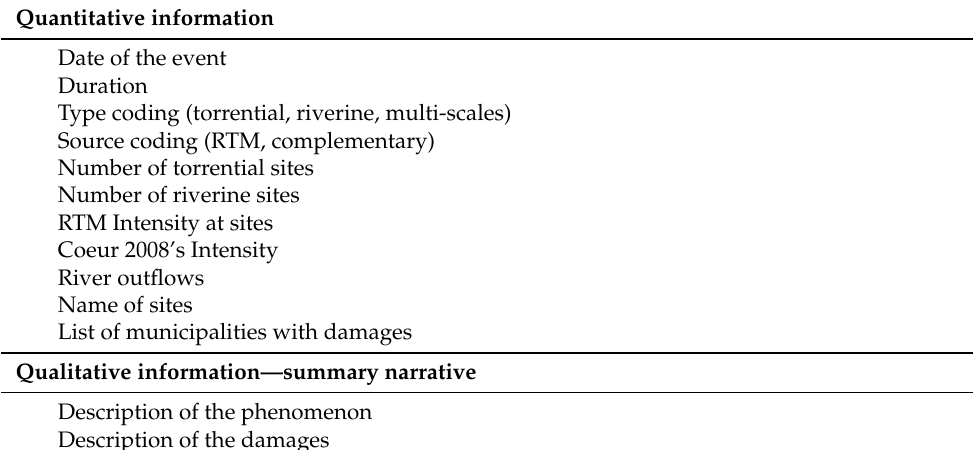
Table 4. Summary description of the content of the Metropolitan